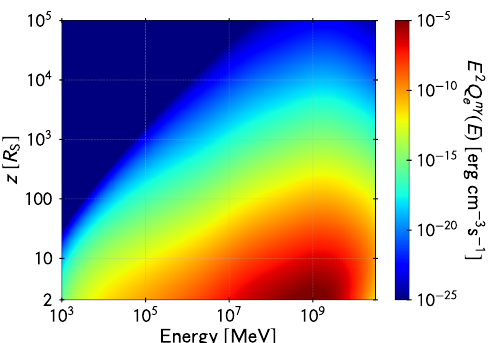
Figure 7. Electron injection in the jet axis via photo-meson production by neutrons in the funnel. The vertical axis is the distance to the hole in units of Schwarzschild radii and the horizontal axis is the energy of the created electron. The color map represents the energy density injected in electrons per unit logarithmic bin of electron energy per unit time.